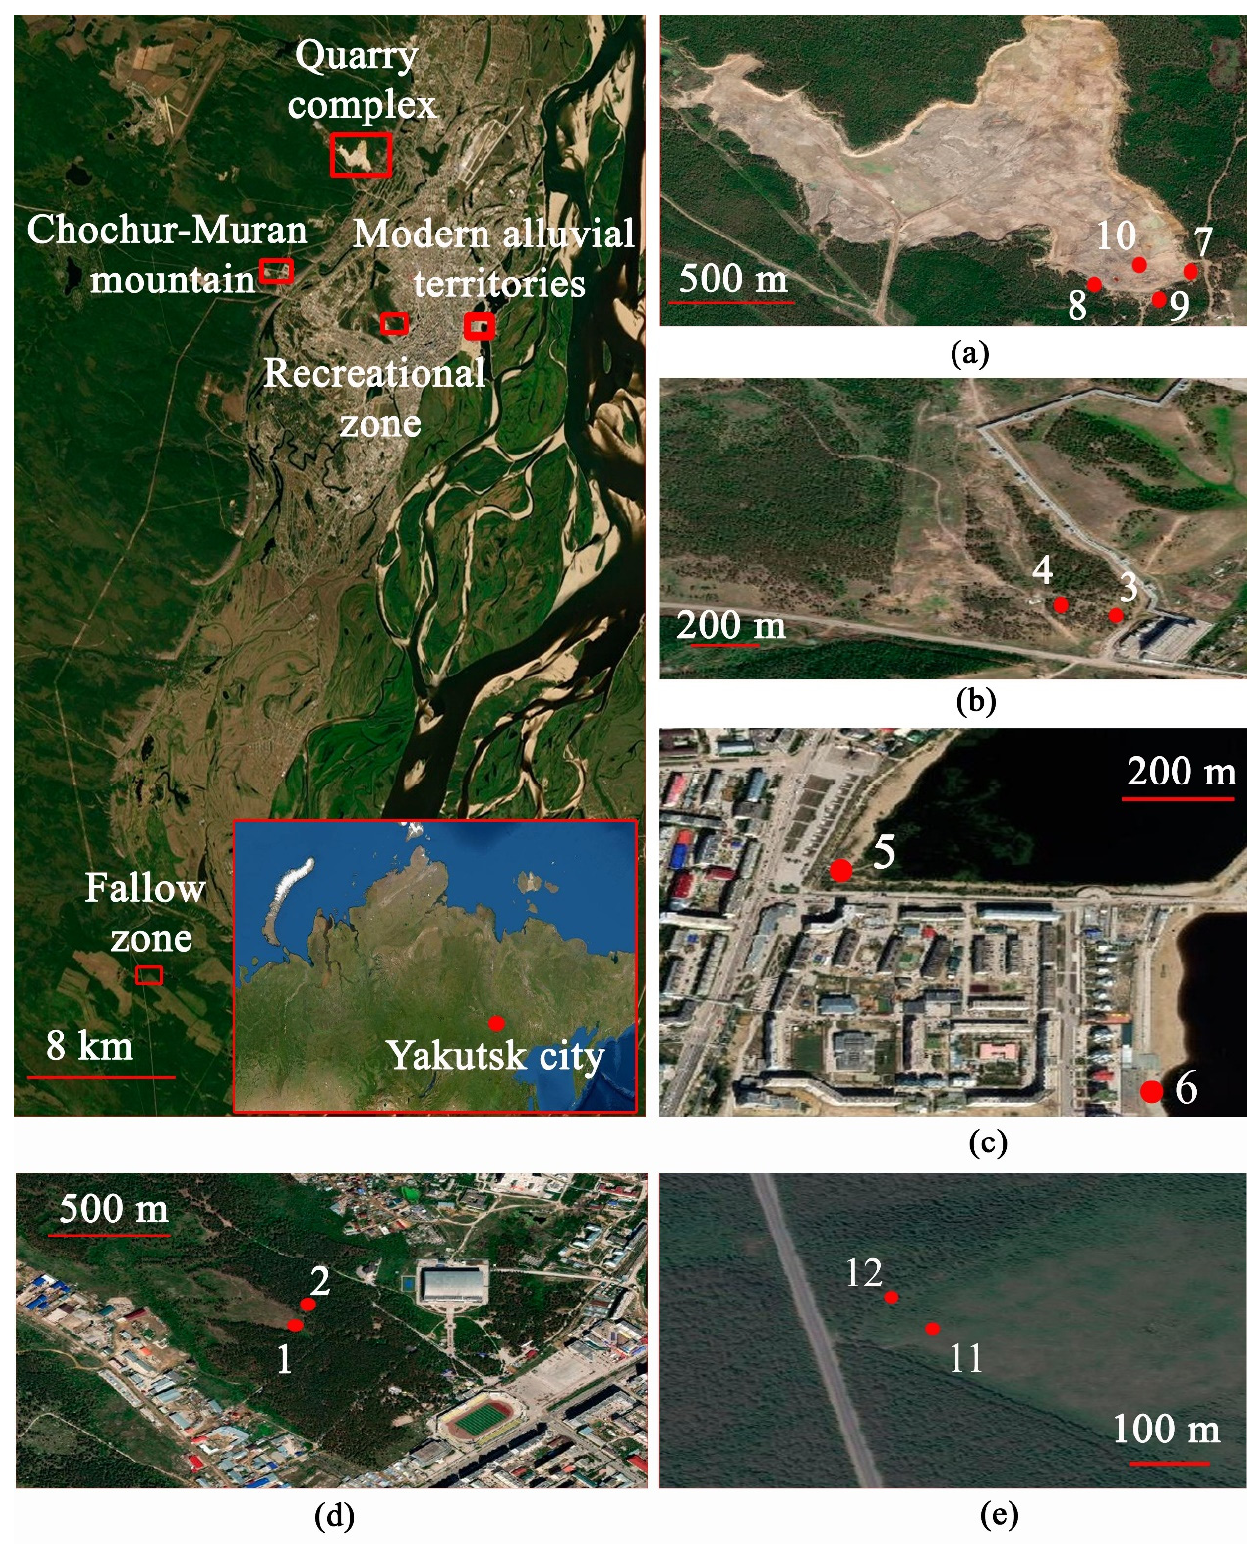
Figure 1. The study area. Yakutsk city. ( a )—quarry complex, ( b )—Chochur-Muran mountain, ( c )—modern alluvial territories, ( d )—recreational zone, ( e )—fallow lands. The soil ID correspond to Table 1. During the work, 12 soil sections were made (Figure 2).